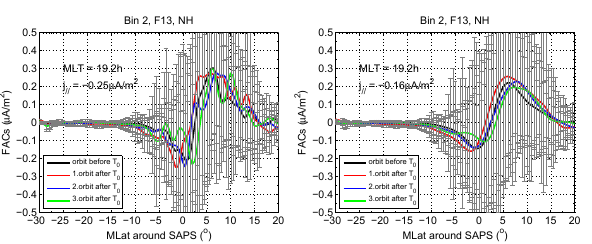
Fig. 1. One example of CHAMP concurrent orbit in bin 2 ( MLT SAPS toMLT SAPS + 2 h ) with respect to DMSP detected SAPS. From top to bottom are CHAMP and DMSP orbit segments in the ionosphere, iono- spheric Pedersen conductivity and the plasma convection velocity in the east-west direction from DMSP, as well as field-aligned currents from CHAMP. The peak velocity of SAPS is indicated by the dashed line. The UT,MLat,andMLTwhenDMSPandCHAMPpassestheregionwhereSAPSpeaksarelisted.